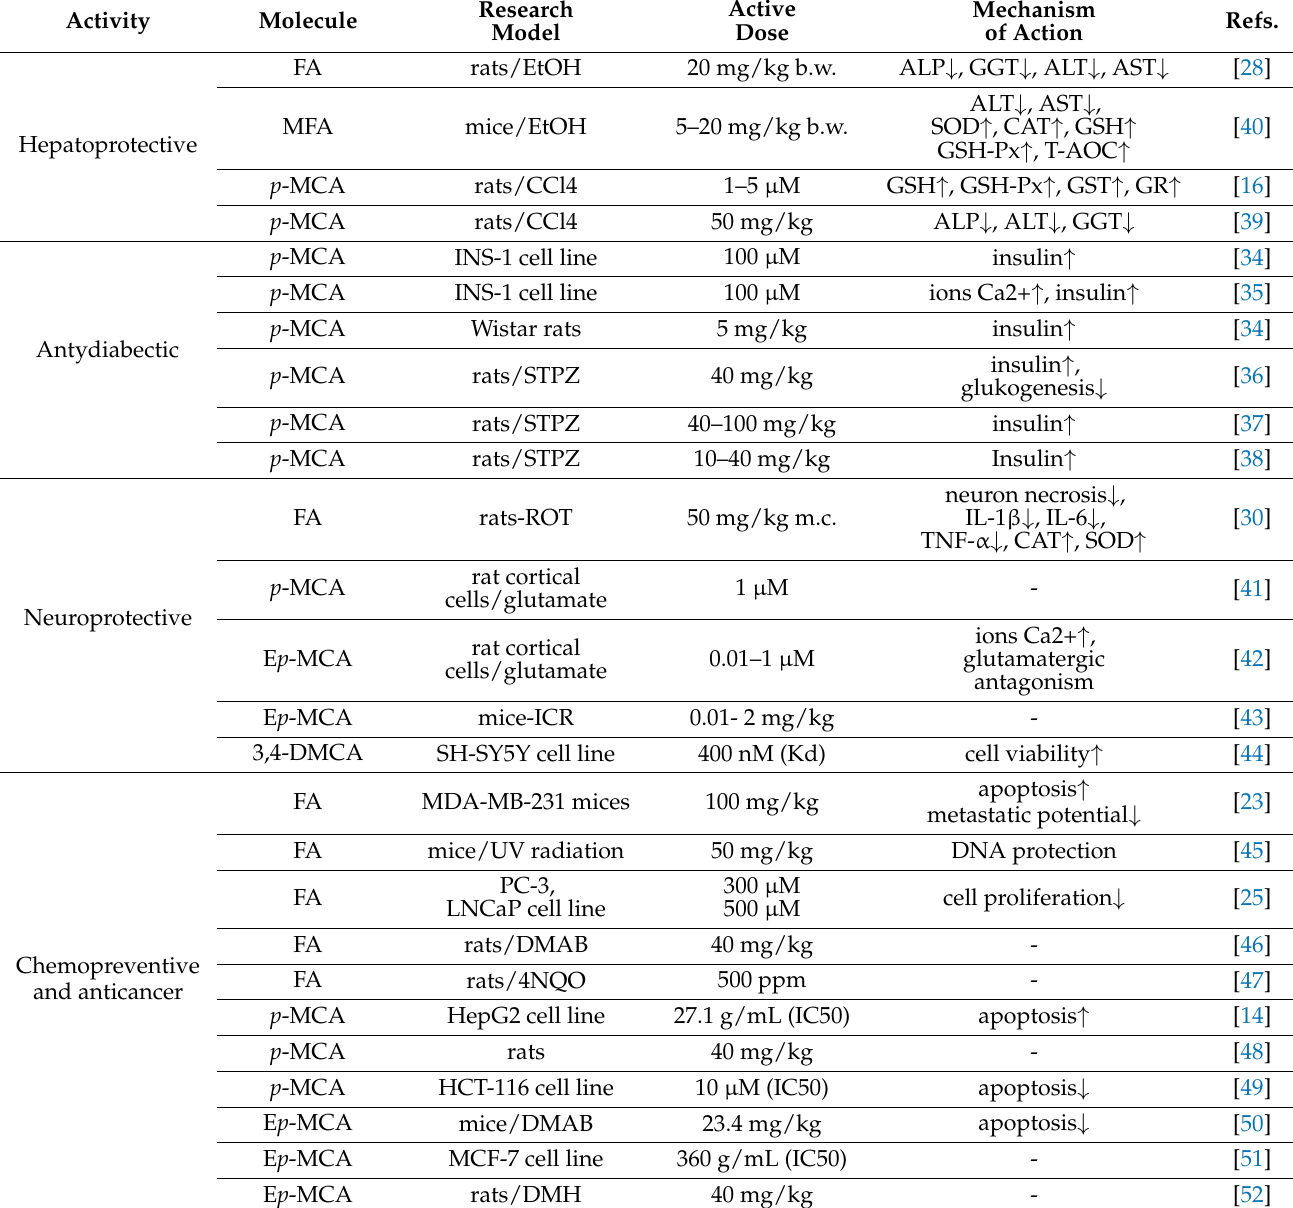
Table 1. Biological potential and mechanism of action of methoxy phenylpropenoic